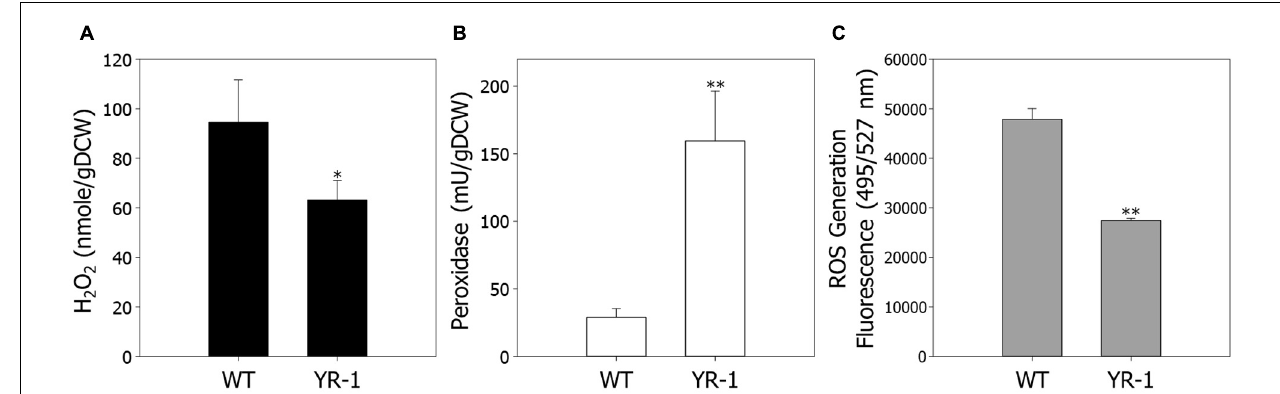
FIGURE 4 | Comparison of endogenous ROS levels in the wild-type and YR-1 mutant. Precultured cells were inoculated into 100 mL of modified Sistrom’s medium in serum bottles. (A) Measurement of endogenous hydrogen peroxide. (B) The activity of endogenous peroxidase. (C) Generation of ROS in cells. ROS were detected using the fluorescence dye CM-H 2 DCFDA and represented in arbitrary units. The fluorescence intensity was normalized to the optical densities of the samples. Experiments were conducted in triplicate and error bars indicate standard deviation of mean. Asterisk represents statistically significant difference, as determined by a Student t -test ( ∗ P < 0.05 and ∗∗ P <